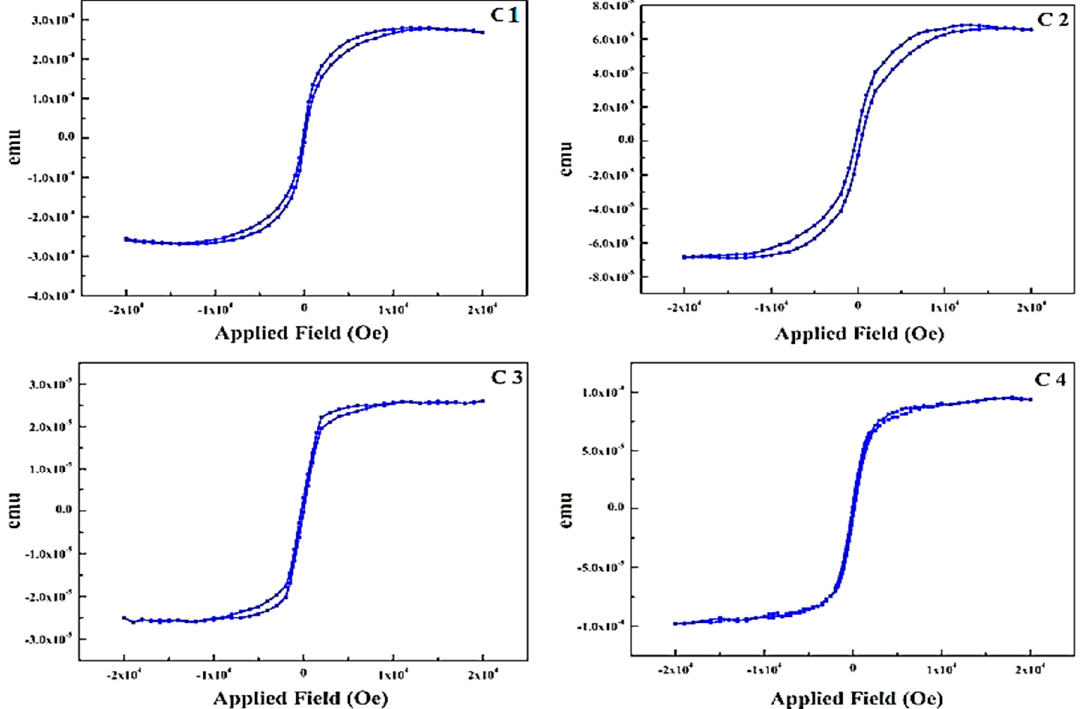
Figure 8 . Magnetization measurements for FeN thin films at varying deposition time span and fixed flow rates of N 2 = 10 sccm ( C1 ) 20 min; ( C2 ) 30 min; ( C3 ) 45 min; ( C4 ) 55 min.